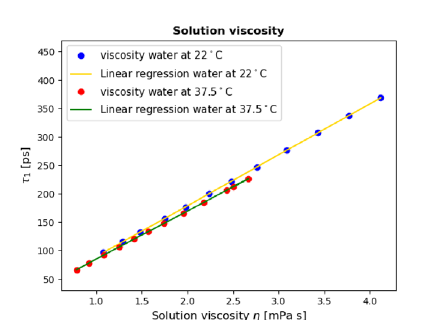
(a) Calculated viscosity as a function of the GABA (b) Extracted relaxation time of GABA as a function of concentration in deionized water at 22°C and 37.5 °C. calculated viscosity in deionized water at 22°C and 37.5 °C. The X-axis represents the solution viscosity in The X-axis represents GABA concentration ranging from 0.5 m to 6.0 m, the Y-axis represents the viscosity mPa s, the Y-axis represents the relaxation time of in mPa s. GABA in ps. Figure 6. ( a ) Shows the calculated viscosity for different GABA concentrations, and ( b ) shows the correlation between GABA solution viscosity and the GABA relaxation time. The GABA relaxation time τ 1 used was the extracted relaxation time at a concentration range of 0.5 m to 6.0